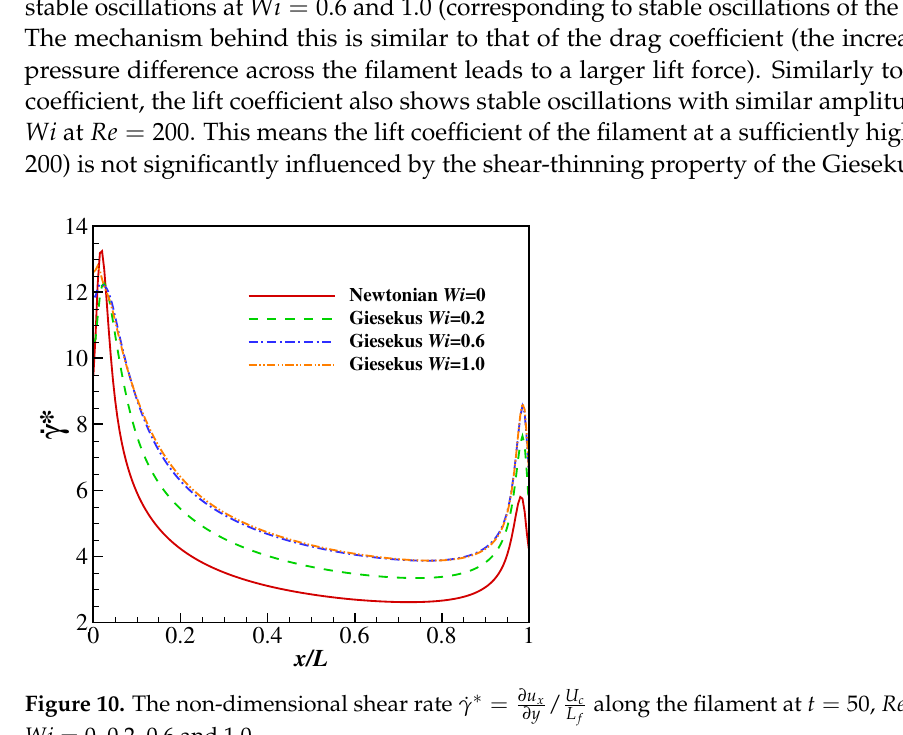
/ U c along the filament at t = 50, Re = 10 and L f ∂ y